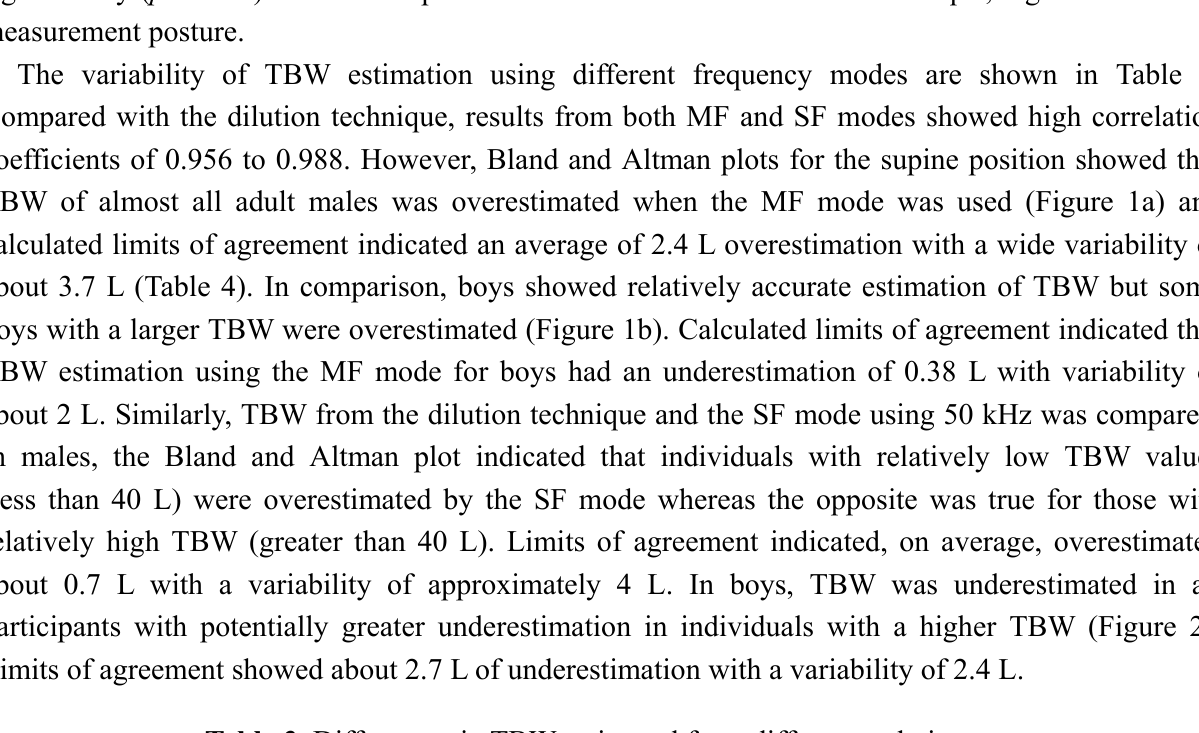
Table 3. Differences in TBW estimated from different techniques.